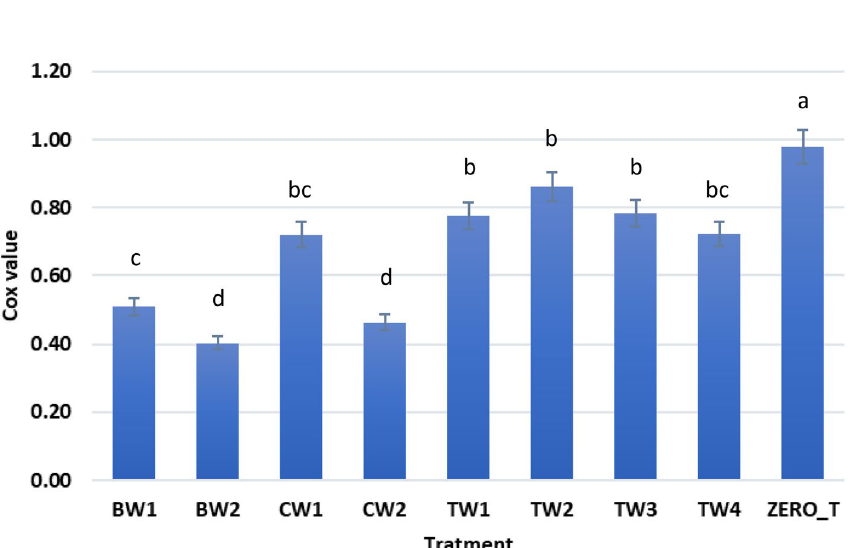
Figure 8. Oxidizability values of cheese